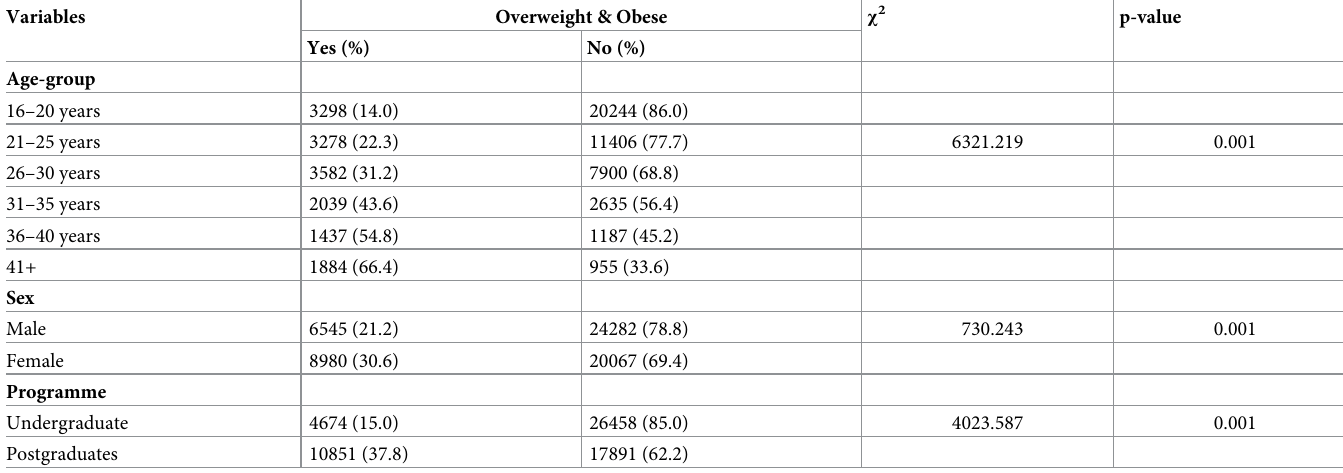
Table 4. Bivariate analysis showing the association between socio-demographic characteristics of students and overweight & obesity. Variables